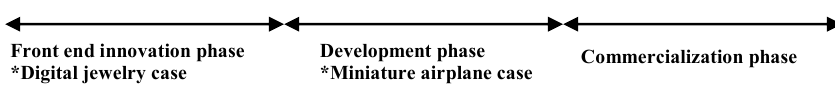
Fig. 4. Differences of the case studies, based on the phase of the innovation